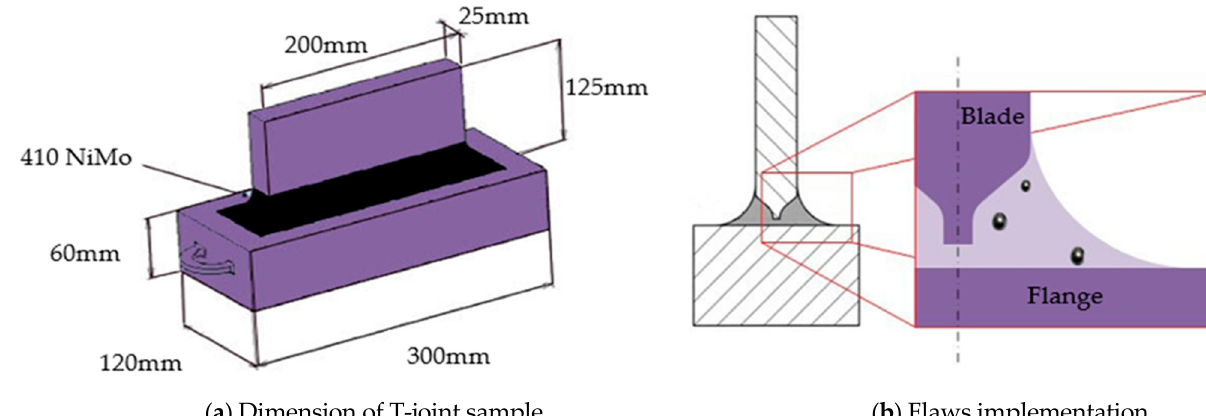
Figure 1. The experiment setup overview.